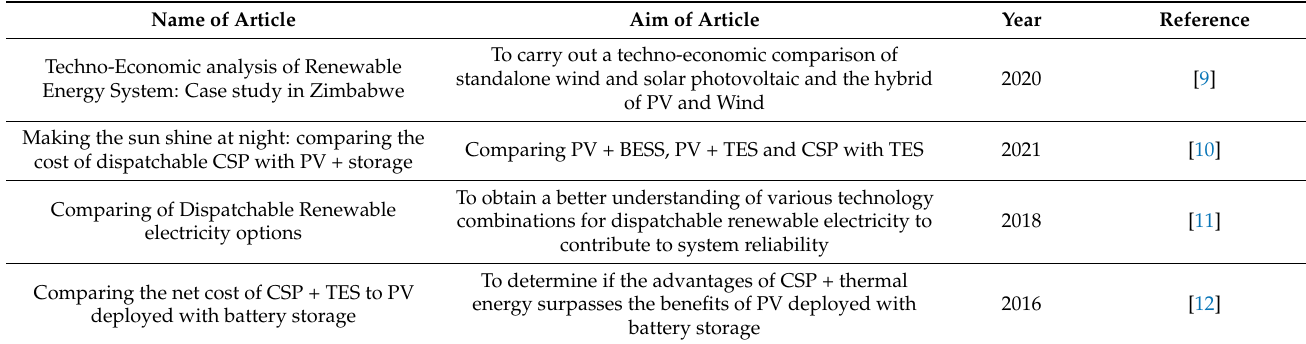
Table 1. Selected techno-economic analysis of renewable energy existing in the